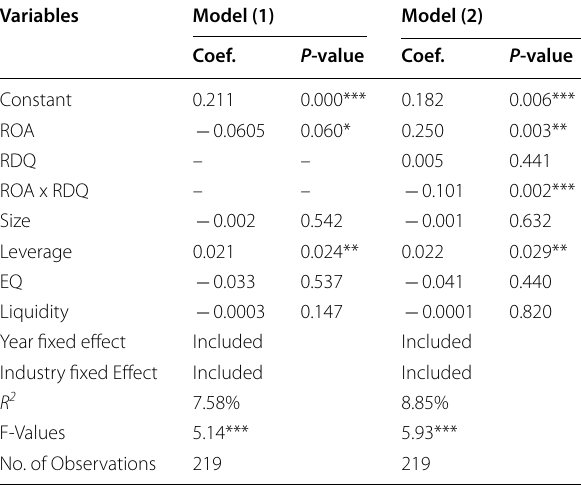
*Significant at level 10%, **Significant at level 5%, ***Significant at level